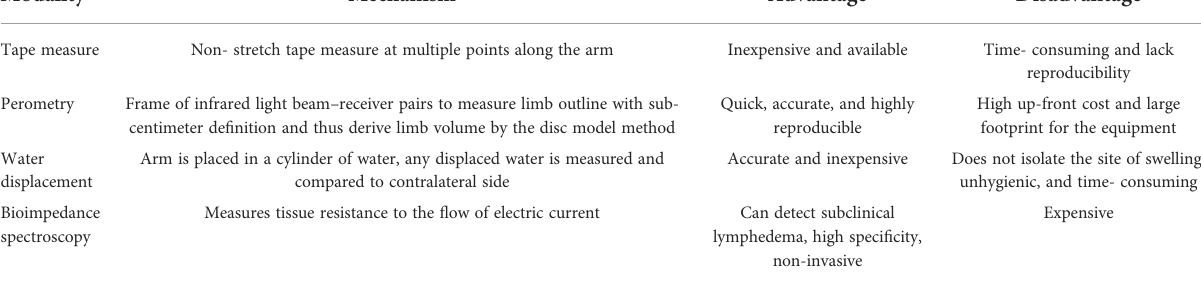
TABLE 1 Assessment tools for